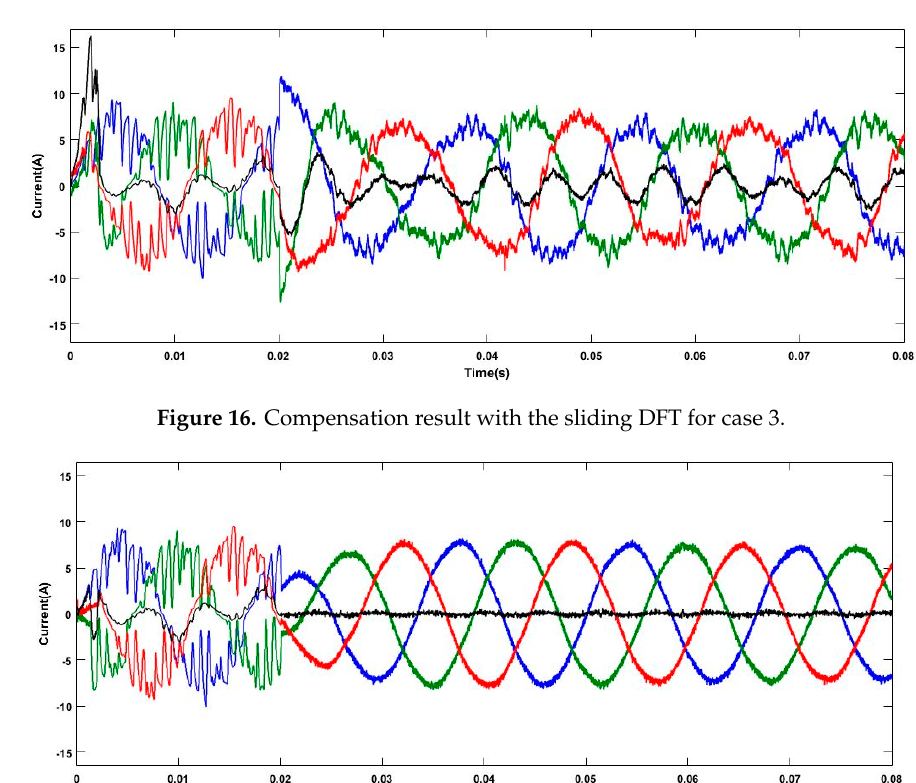
Figure 15. Compensation result with the traditional p-q method for case 3.